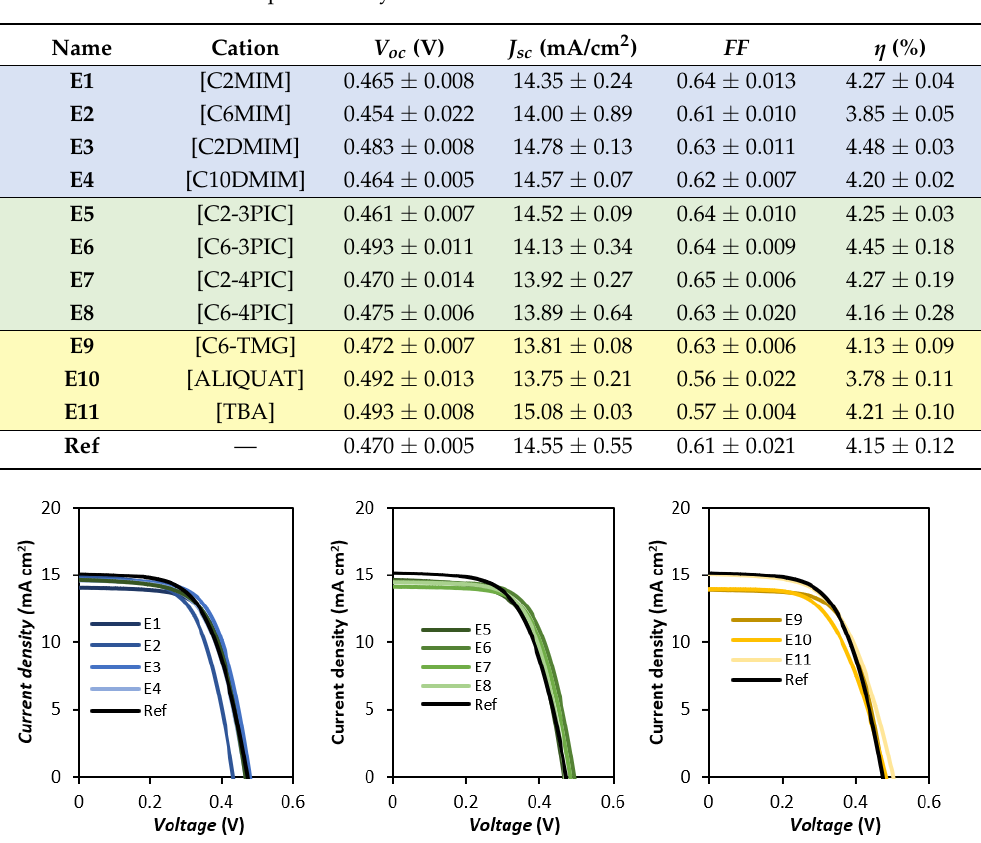
Table 2. Performance values of the test cells employing the various iodide-based organic salts as additives under 100 mW cm −2 AM 1.5G illumination. The results correspond to the average of five measurements of two cells per electrolyte mixture.